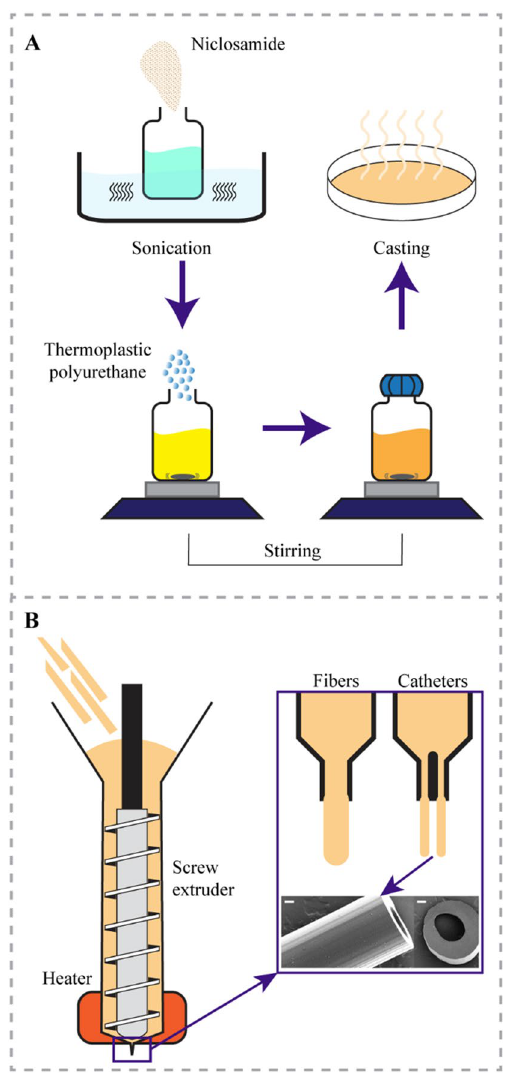
Figure 1. Process for ( A ) incorporating NIC into the polymeric matrix of TPU using solvent casting and ( B ) for producing fibers and catheters using HME technology. Scale bar in B is 200